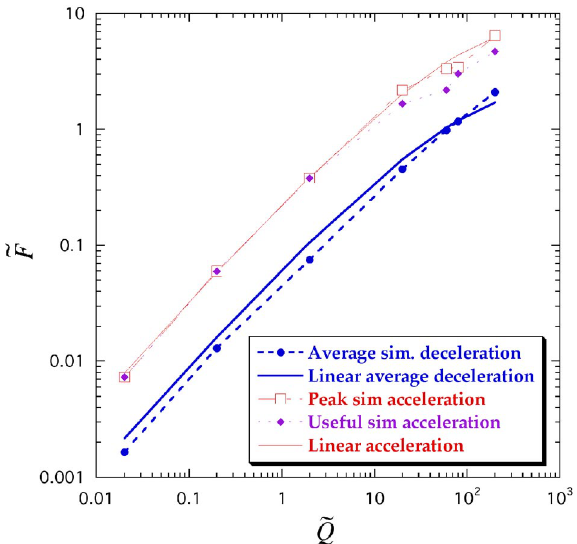
FIG. 10. (Color) The average normalized energy loss rate of ~ FF (cid:4) e jh E ij =m c! of a Gaussian-current electron beam z e p dec (cid:1)(cid:1)(cid:1)(cid:1)(cid:1)(cid:1)(cid:1)(cid:1)(cid:1) ~ p (cid:4) 0 : 1 , using experimental scaling, ~ aa (cid:4) 0 : 2 (cid:3) QQ= 2 , with k p z as a function of ~ QQ , from linear theory (solid bold line) and self- consistent PIC simulation (circles), the peak accelerating field (cid:4) e j E j =m c! , from linear theory behind the beam, ~ FF z; max e p max (solid fine line) and PIC simulation (squares), and the useful field for acceleration